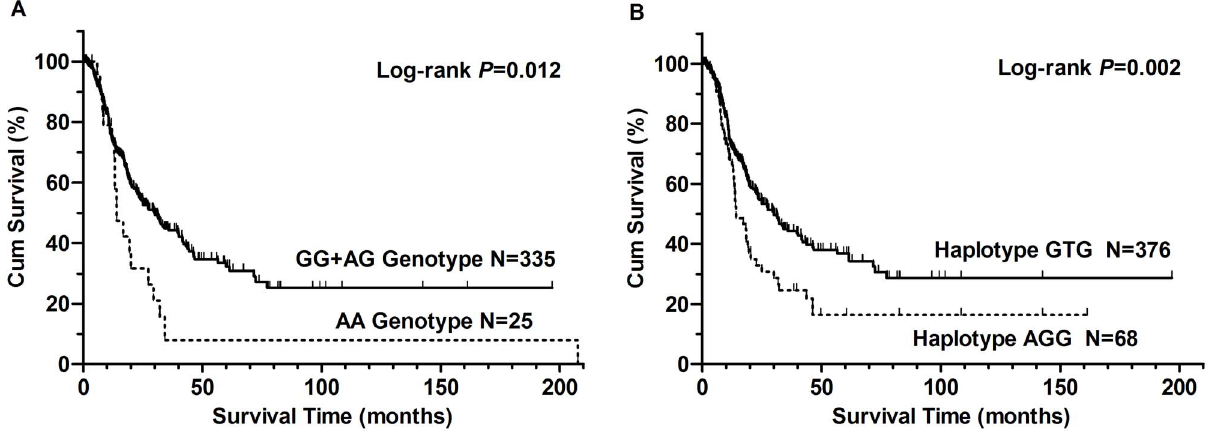
Figure 1. Kaplan-Meier curve of overall survival according to (A) ERCC2 rs1799793 polymorphism and (B) ERCC1 - ERCC2 haplotype.